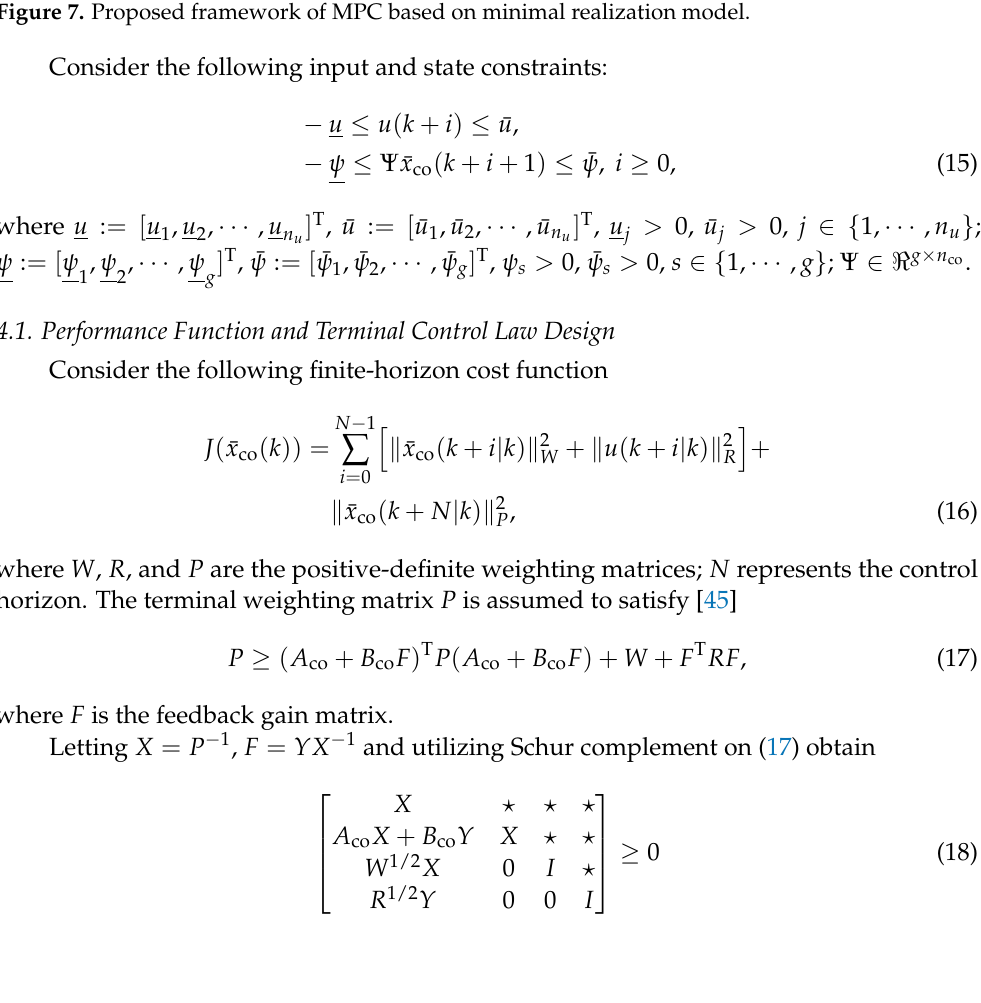
Figure 7. Proposed framework of MPC based on minimal realization